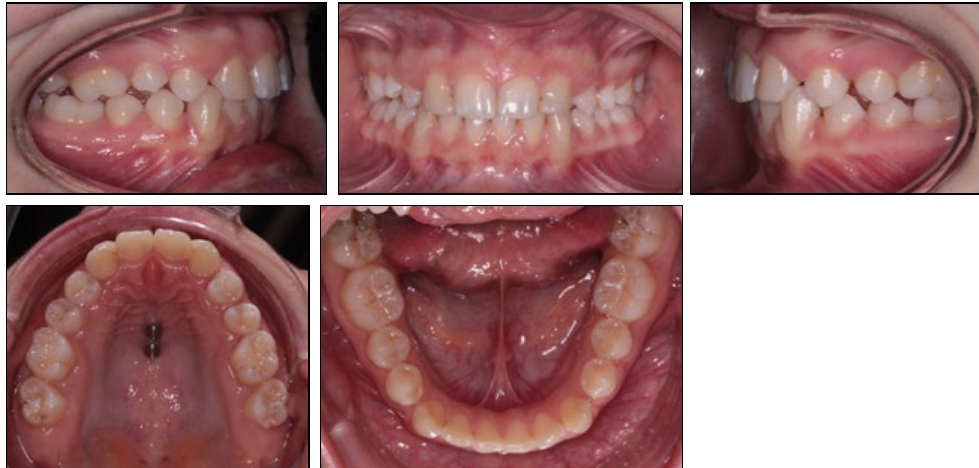
Figure 10. Intraoral photographs prior to insertion of the fully individualised lingual appliance (WIN®).